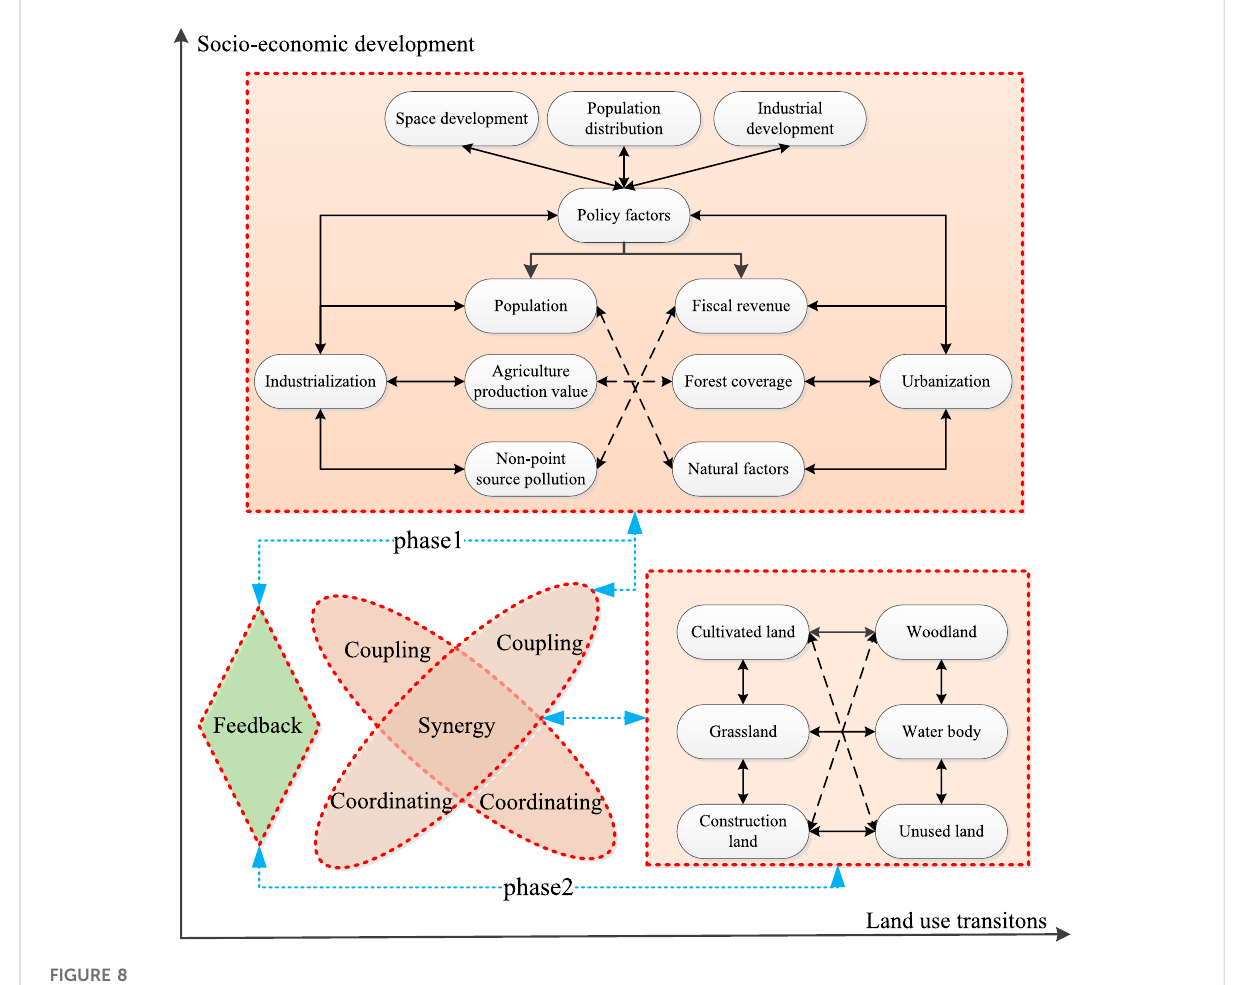
FIGURE 8 Mechanism of land use transitions in the Chengdu-Chongqing